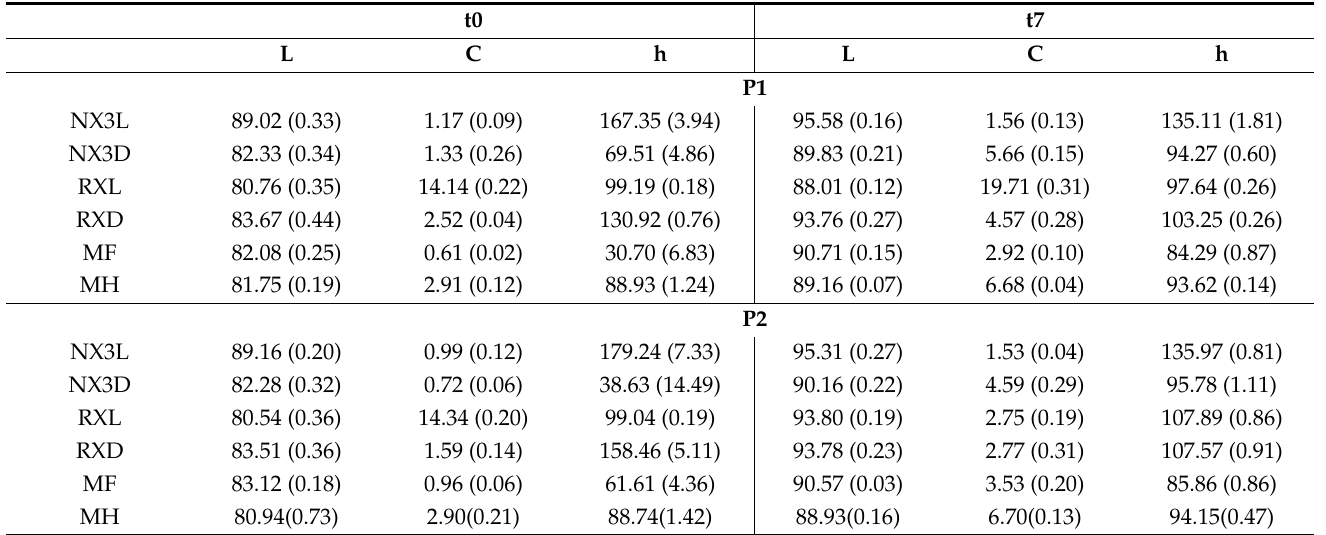
NX3L = NX3 light-cure, NX3D = NX3 dual-cure, RXL = RelyX Veneer, RXD = RelyX Ultimate, MF = Enamel Plus HRi Flow, MH = Enamel Plus HRi. Regarding ∆ E, the results are shown in Figure 2. At t1, MF(P1) and MH(P2) achieved